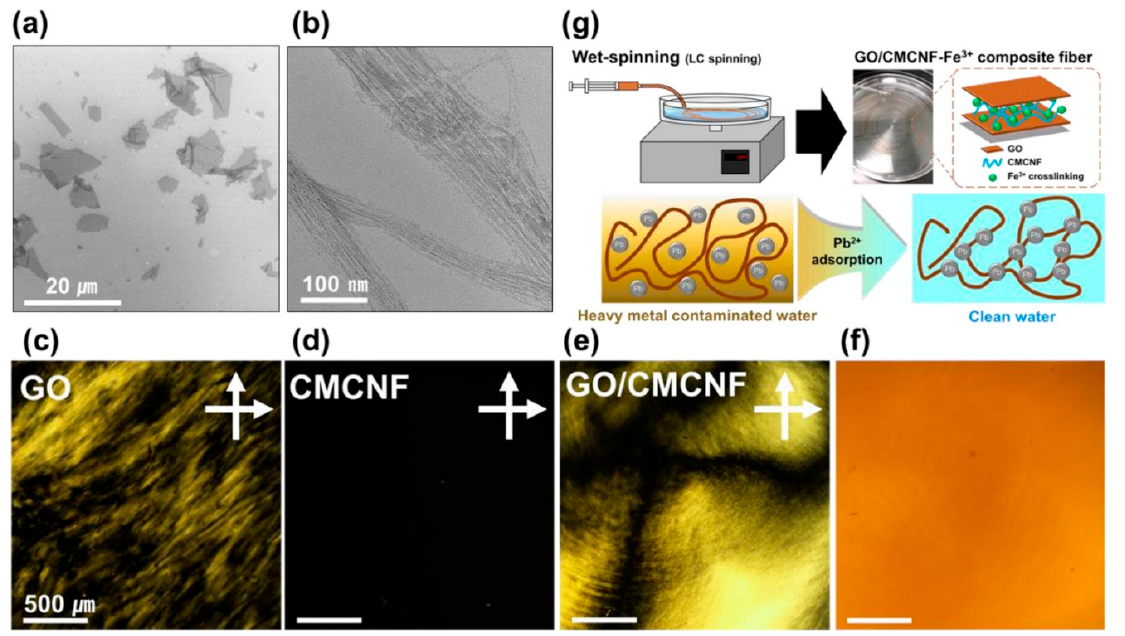
Figure 3. ( a ) SEM images of exfoliated GO sheets. ( b ) TEM image of CMCNF morphology. POM images of ( c ) GO at 0.5 wt. %, ( d ) CMCNF at 2 wt. %, ( e ) GO/CMCNF (5/5) mixture at 0.5 wt. %. ( f ) Optical microscope image of an identical area corresponding to ( e ). ( g ) Schematic diagram of GO/CMCNF-Fe 3+ CF with Pb 2+ adsorption from aqueous media (reproduced from [96] with permission of Elsevier, 2020).